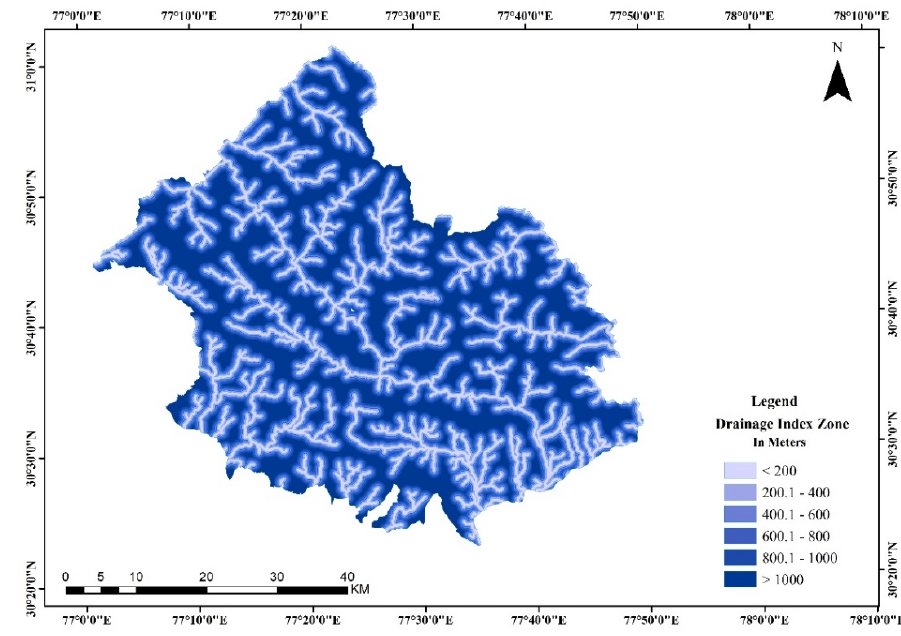
Figure 11. Drainage buffer risk index.